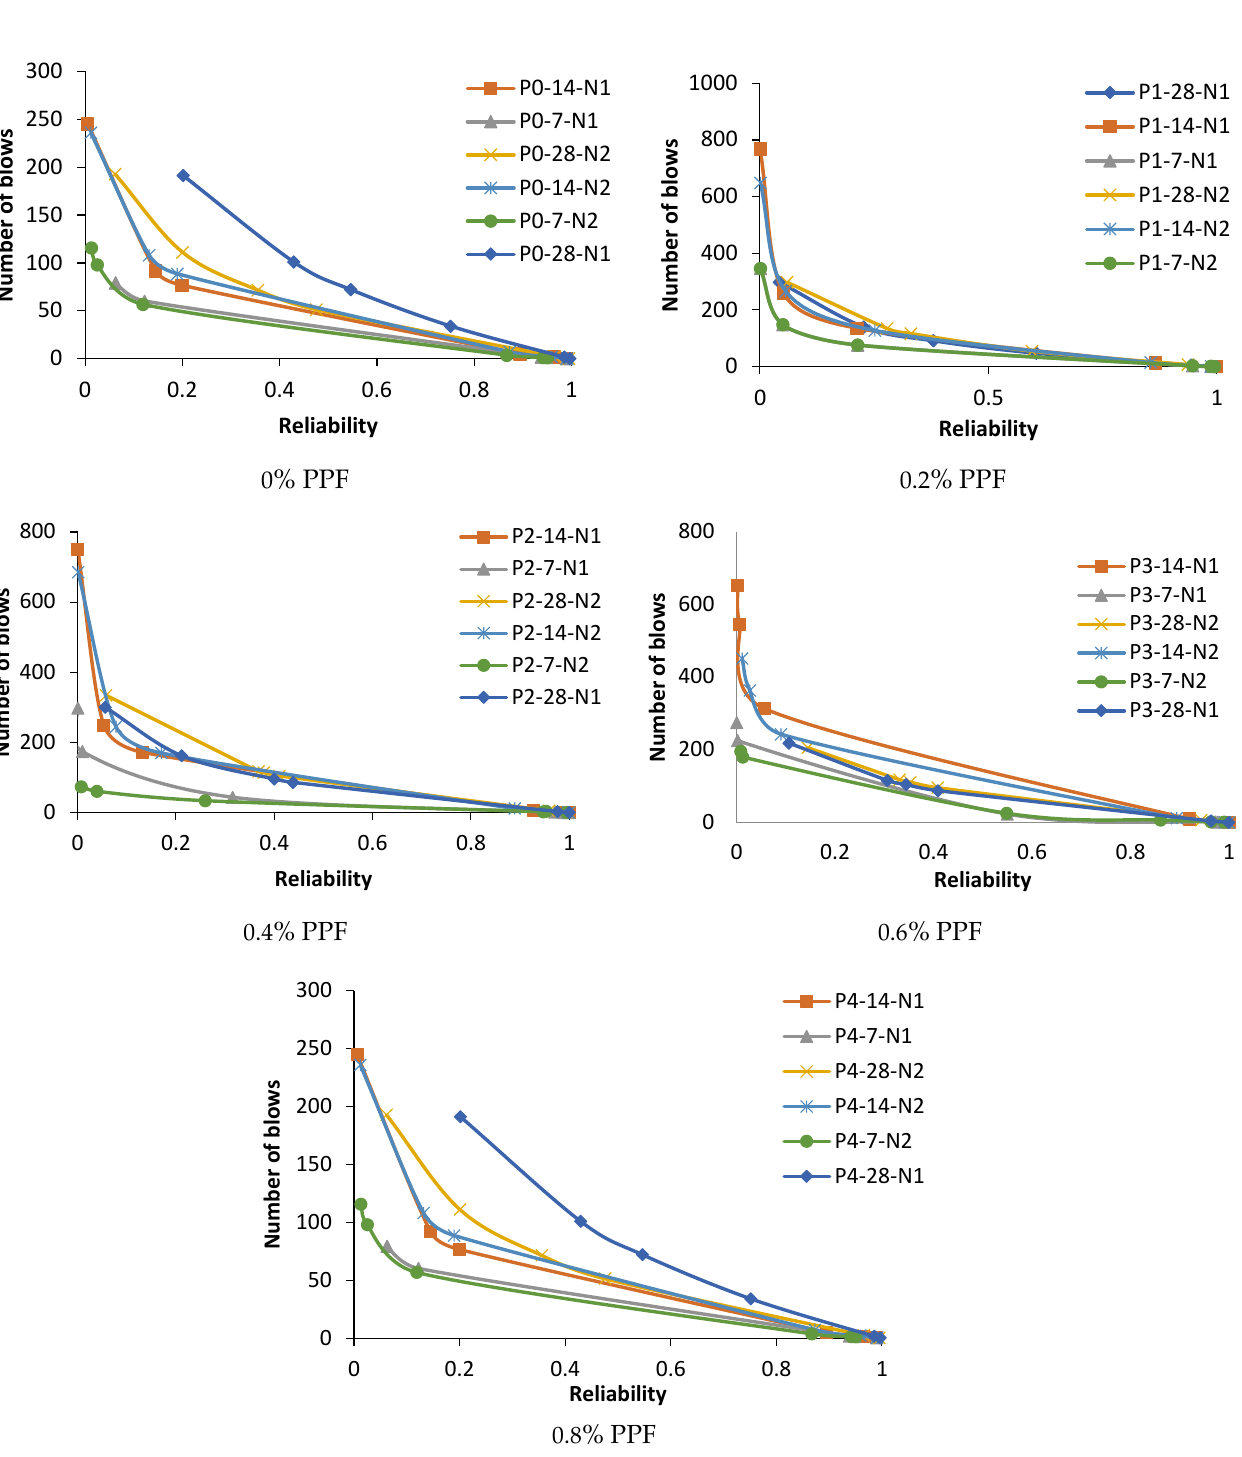
Figure 22. Reliability curves for P0, P1, P2, P3 and P4 mixes.